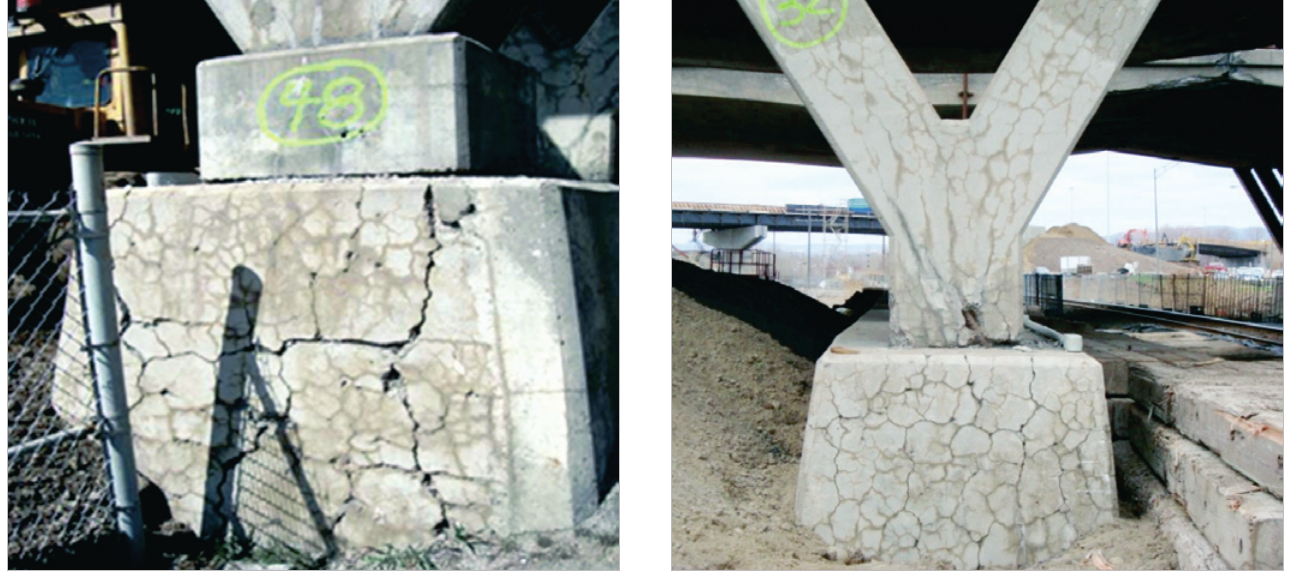
Figure 1) and the loss/reductions in mechanical properties,